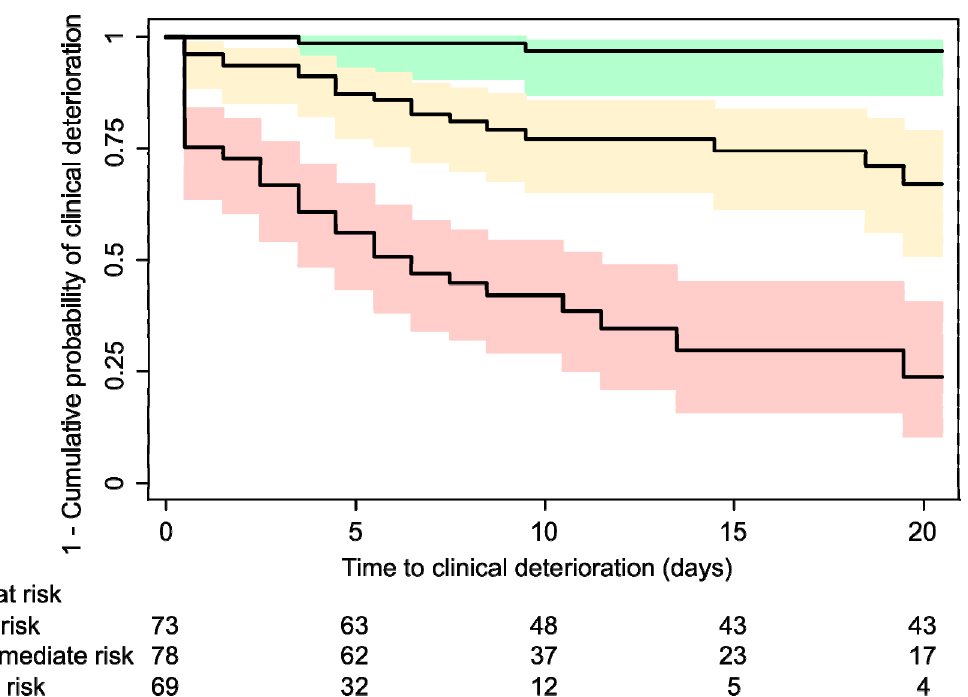
Figure 2. Kaplan–Meier curves by risk-category. The composite endpoint was ICU transfer or death. The 20-day event-free survival was 0.97 (95% CI, 0.87–0.99) for the “low risk” group (upper curve), 0.67 (95% CI, 0.51–0.79) for the “intermediate risk” (intermediate), and 0.24 (95% CI, 0.10–0.40) for the “high risk” group (lower curve). CI: confidence interval; ICU: intensive care